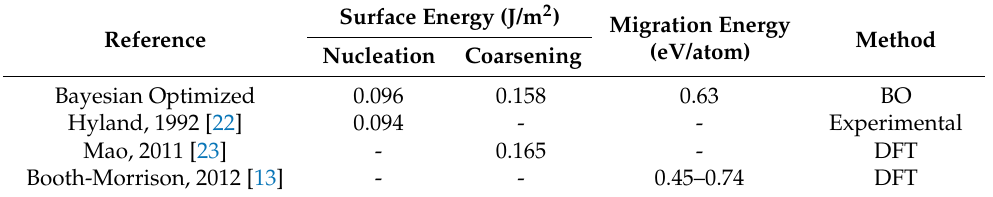
Table 3. Comparison of research and BO ‐ Fitted Al: Al 3 Sc surface energies and migration energy of Sc in Al.